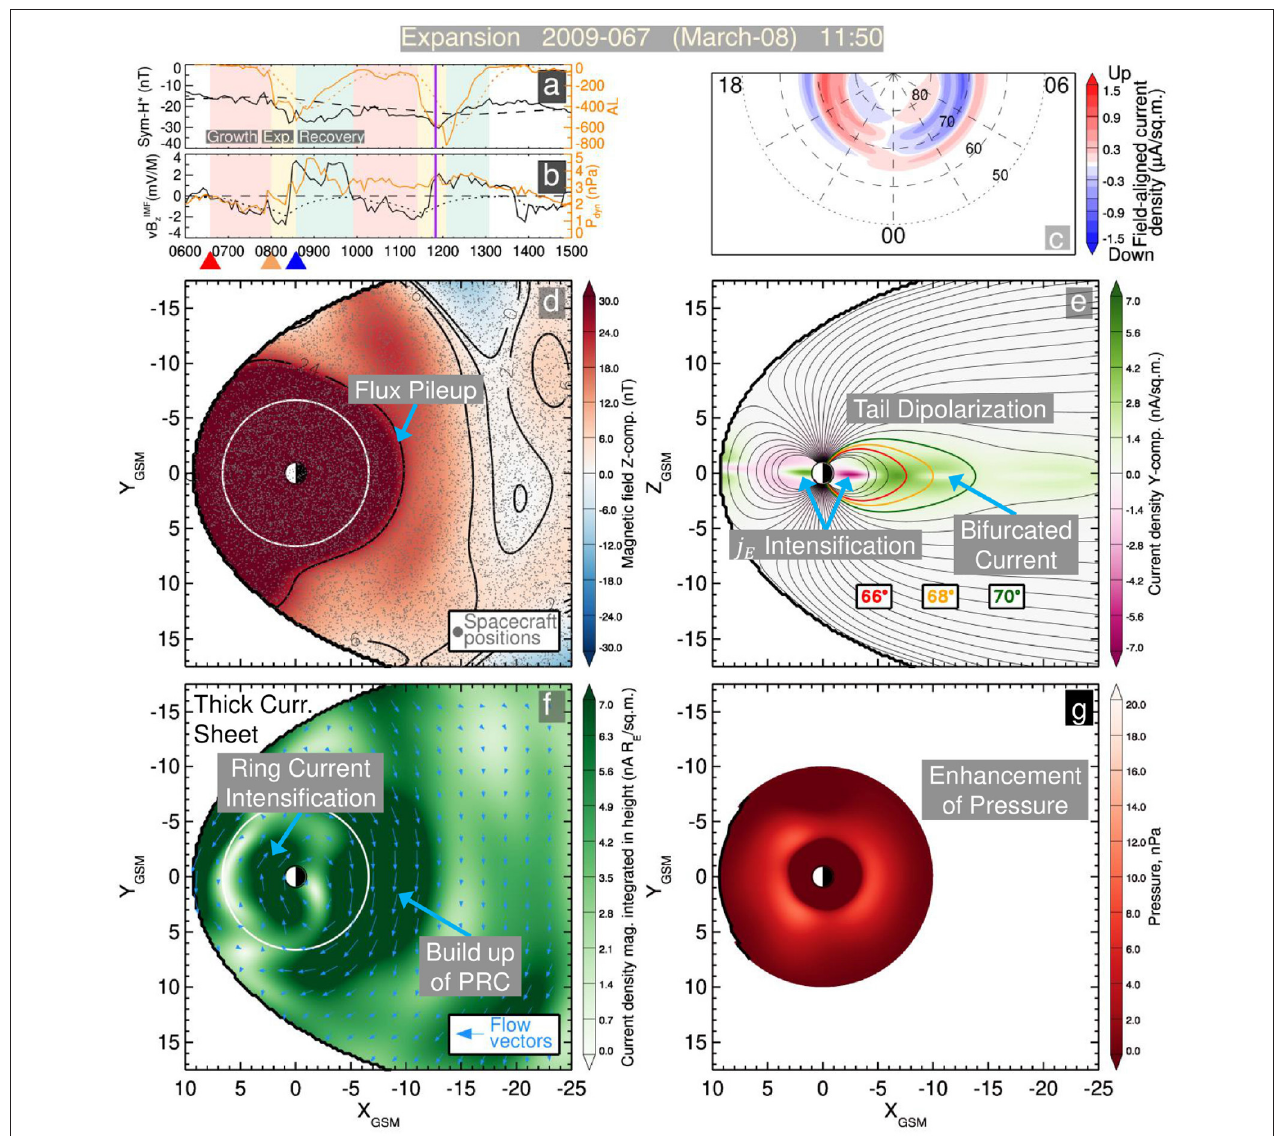
FIGURE 7 | The merged resolution model’s reconstruction of the expansion phase of the 8 March 2009 substorm. Panels are the same as Figure 6 except 25 min